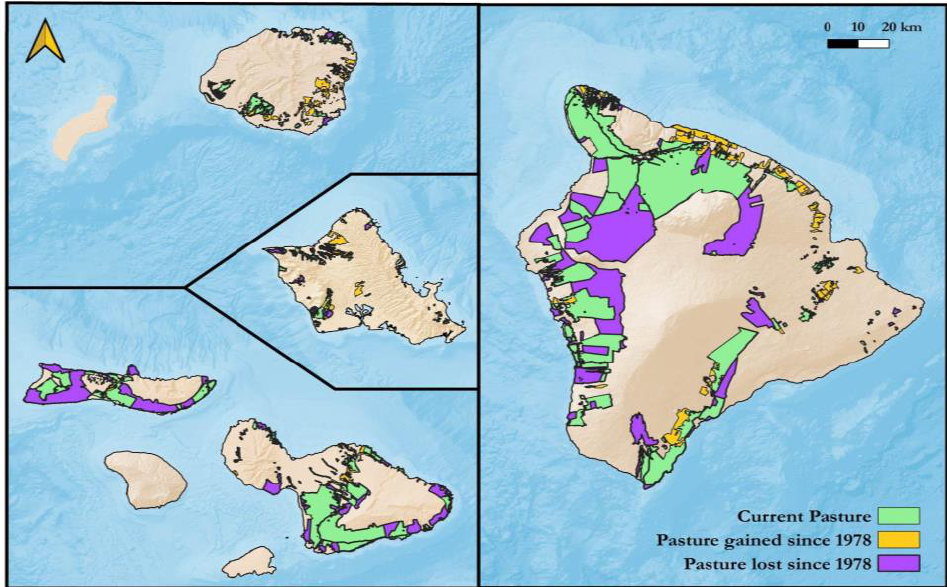
Figure 1. Change in pasture area in Hawai‘i from 1978 to 2015. Light green are areas classified as managed pasture in the 2015 Hawai‘i Agricultural Baseline that have been pasture since at least 1978 [10]. Purple represents land that was classified as pasture in 1978, but not in the 2015 baseline. The orange-yellow represents areas classified as pasture in 2015, that was not classified as such in 1978. From 1978–2015, there was a total decrease of 180,055 ha of pasture (purple), and a gain of 41,088 ha (orange-yellow). A 2020 Agricultural Baseline update [35] of a subset of islands found an additional decrease of 175 hectares of pasture on O ʻ ahu, 891 hectares on Hawai‘i Island, and a gain of 167 hectares on Kaua̒i. Pasture gained was primarily sugar plantation in 1978, and pasture lost is now primarily fallow agricultural land or used for military training or restoration, with small areas converted to residential development [10].